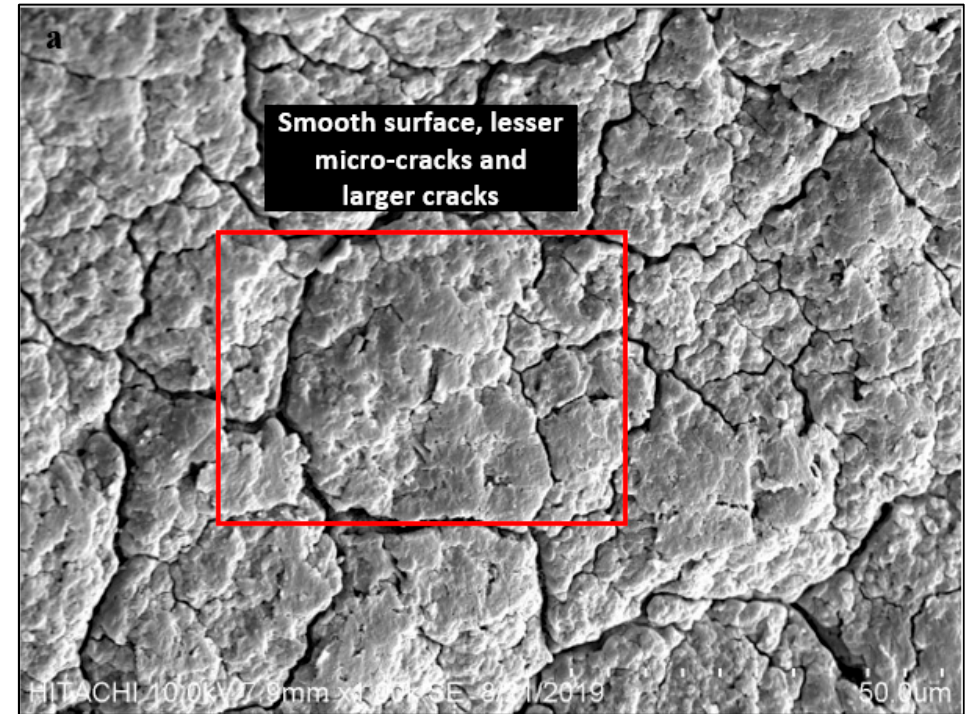
Figure 8. SEM of 10% NaOH treated rubber surface morphology.